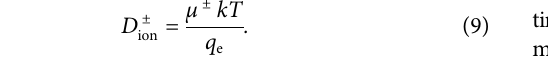
Frontiers in Earth Science |